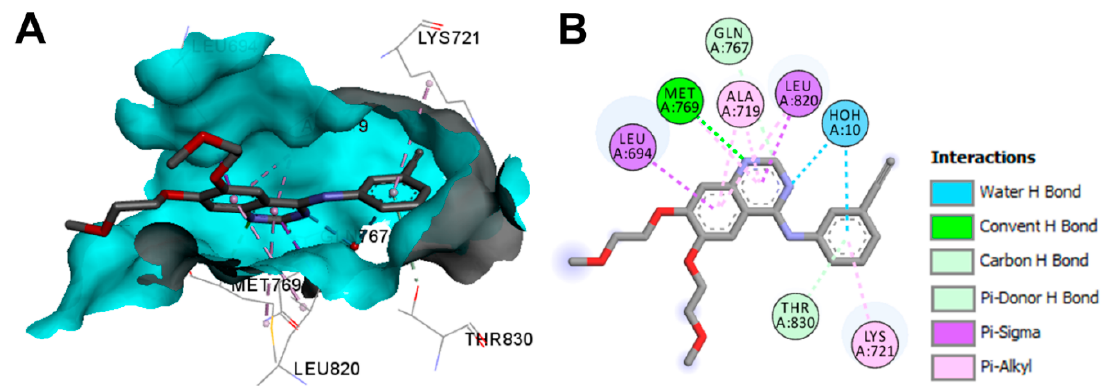
Figure 27. Binding modes of erlotinib (shown as sticks) into wild-type EGFR (pdb: 1M17): ( A ) 3D binding mode, receptor shown as hydrogen bond surface; ( B ) 2D binding mode showing different types of binding interactions; the figure was generated using Discovery Studio Visualizer (V16.1.0.15350).